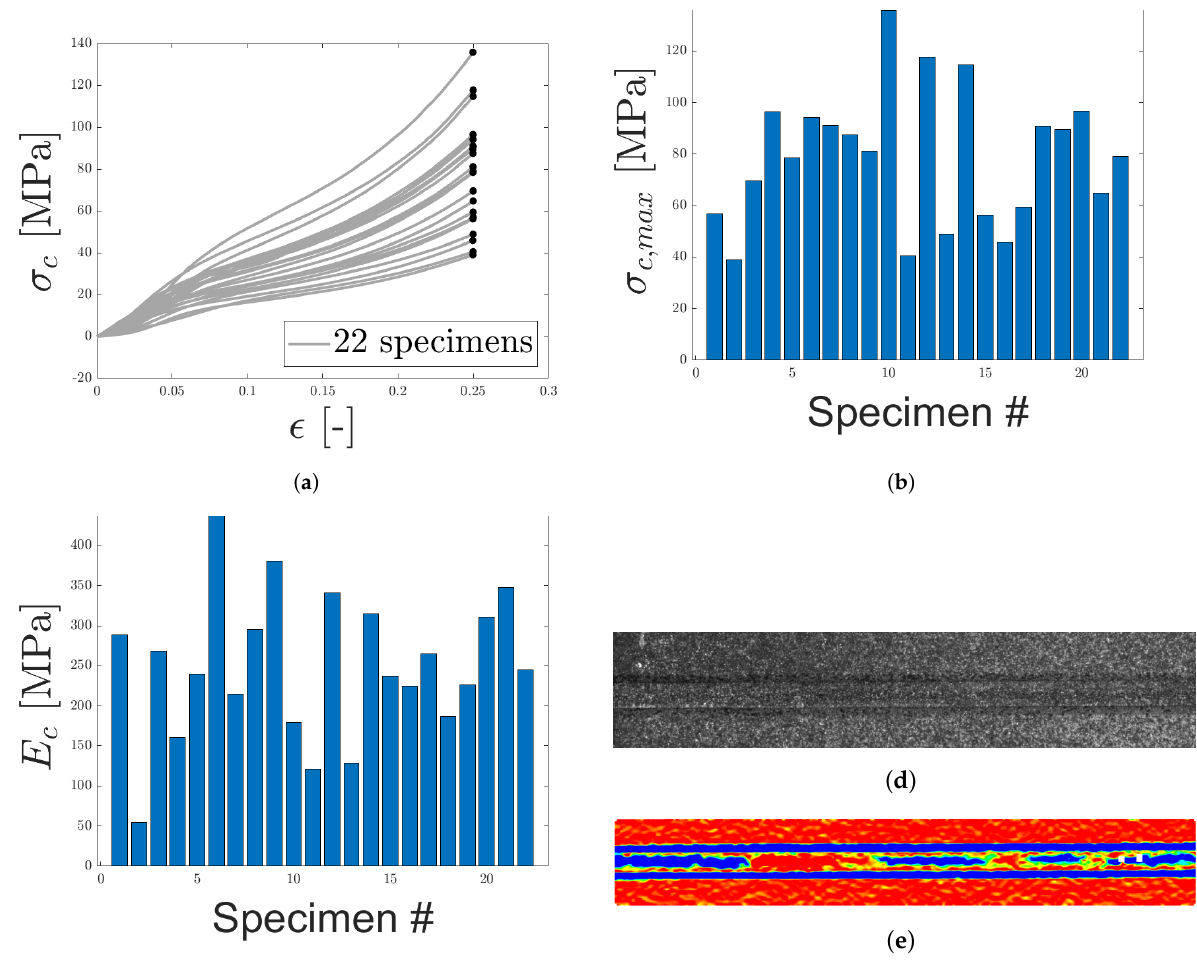
Figure 14. The engineering stress-strain response for LC 2 (uniaxial compression) is presented in ( a ). In ( b , c ) maximum stress and equivalent Young’s modulus are presented. Figure ( d ) contains the speckle pattern for one of the specimens. In Figures ( e ), the strain field along the loading direction, obtained using DIC, is presented.